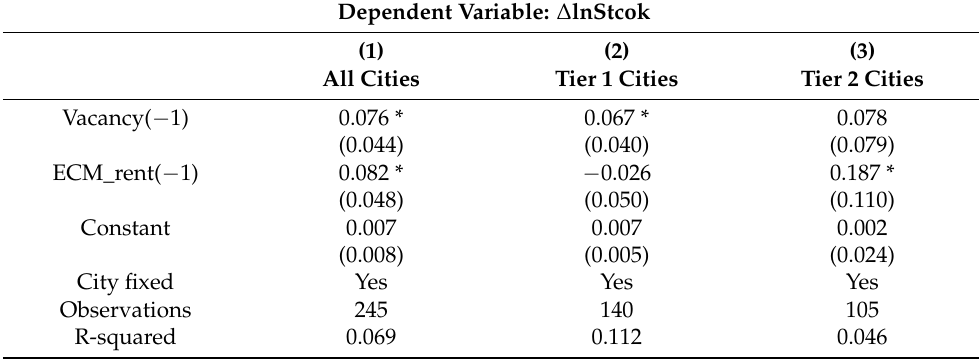
Table 7. Stock change adjustment model result.